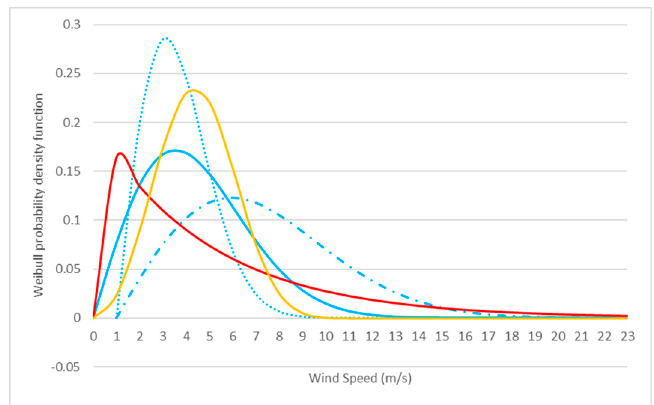
Figure 2. Weibull probability distribution function for di ff erent values of the shape k and scale λ parameters. The blue lines correspond to k = 2 and λ = 3, 5, 7 m/s for the dotted, solid and dash-dotted lines, respectively. The red and yellow solid lines correspond to k = 1, 3, respectively, and λ = 5 m/s .